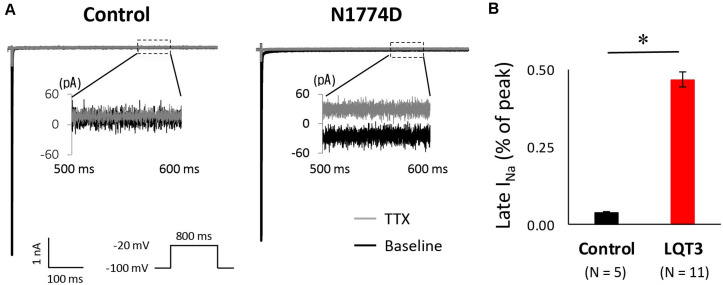
Late sodium current in control and N1774D-hiPSC-CMs. (A) Representative traces of sodium currents in the absence (black line) and presence (gray line) of 20 μM tetrodotoxin (TTX). The used protocol is shown in the lower panel. Inset shows late sodium current between 500 and 600 ms. Tetrodotoxin-sensitive current was calculated by subtraction. (B) Mean late sodium current of control and N1774D channels. Late sodium current is presented as the percentage of late sodium current to peak sodium current. The data pooled from different lines or clones among the control and N1774D group were analyzed. The late sodium current was significantly increased. ∗p < 0.001, vs. control.